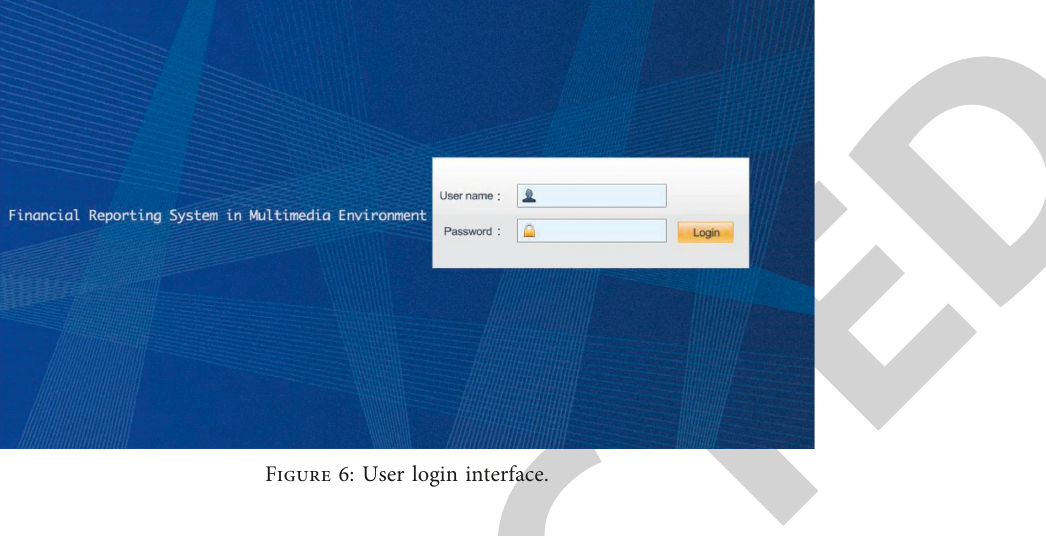
Figure 6: User login interface.